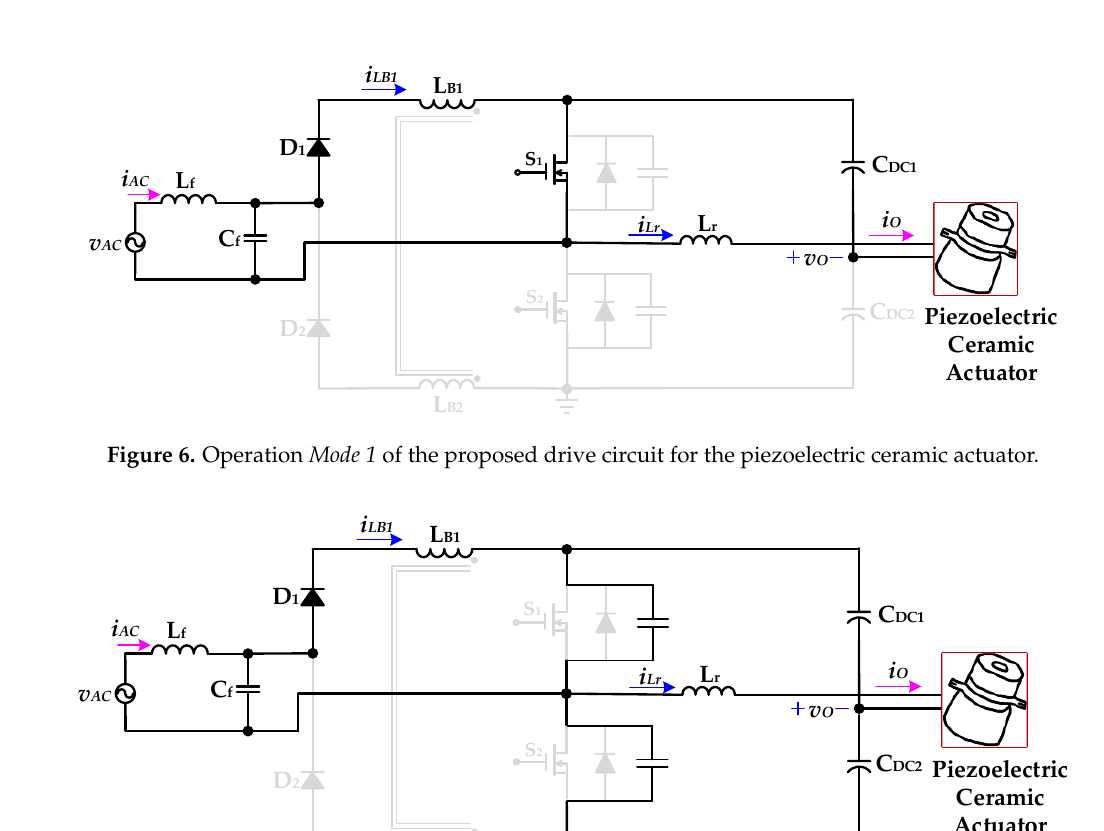
Figure 6. Operation Mode 1 of the proposed drive circuit for the piezoelectric ceramic actuator.